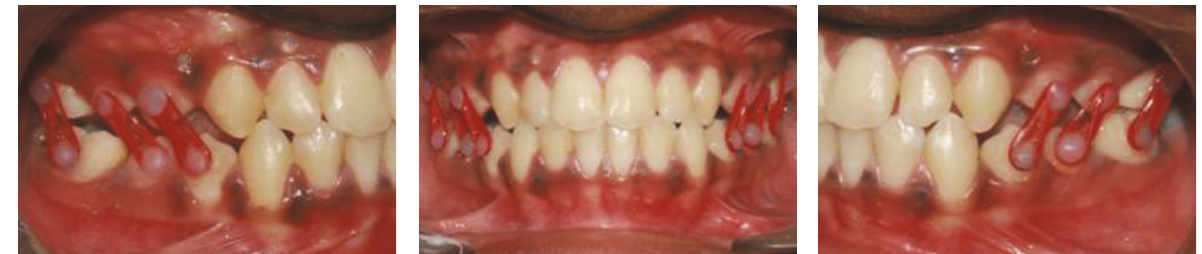
Figure 5: Occlusal